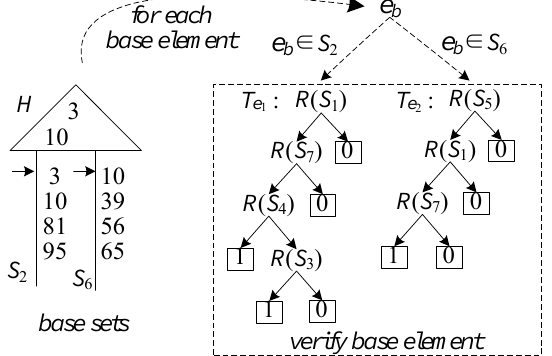
Figure 4. An example of evaluation-tree-based execution